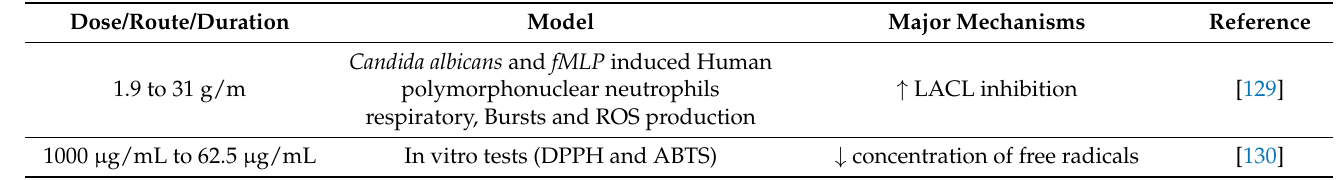
Table 12. The antioxidant actions of α